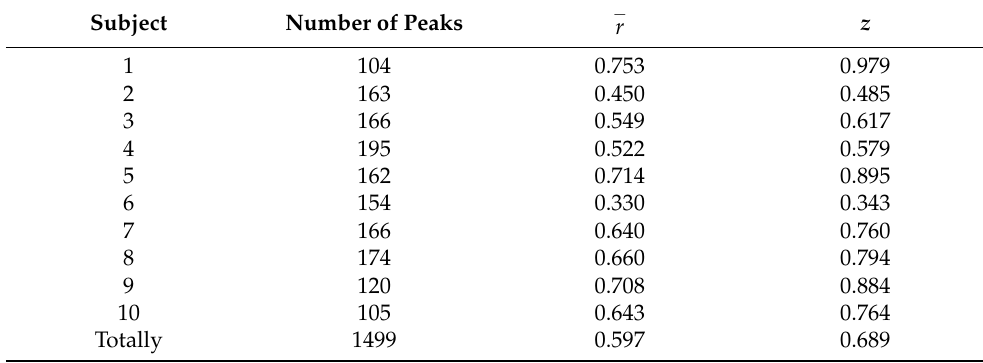
Table 1. Use of the Fisher’s Z-transformation and averaged Pearson’s correlation coefficient to confirm − r = 0.6, p < 0.001) in amplitude of the hypothesis about similarities between measured pulse waves ( − r is averaged Pearson’s correlation coefficient for suprasystolic pulsations and Finapres’s MAP, where patient a z is a result of Fisher’s Z-transformation. In one subject, there were troubles with measured MAP by Finapres, so he was not included in this comparison between Amplitude and